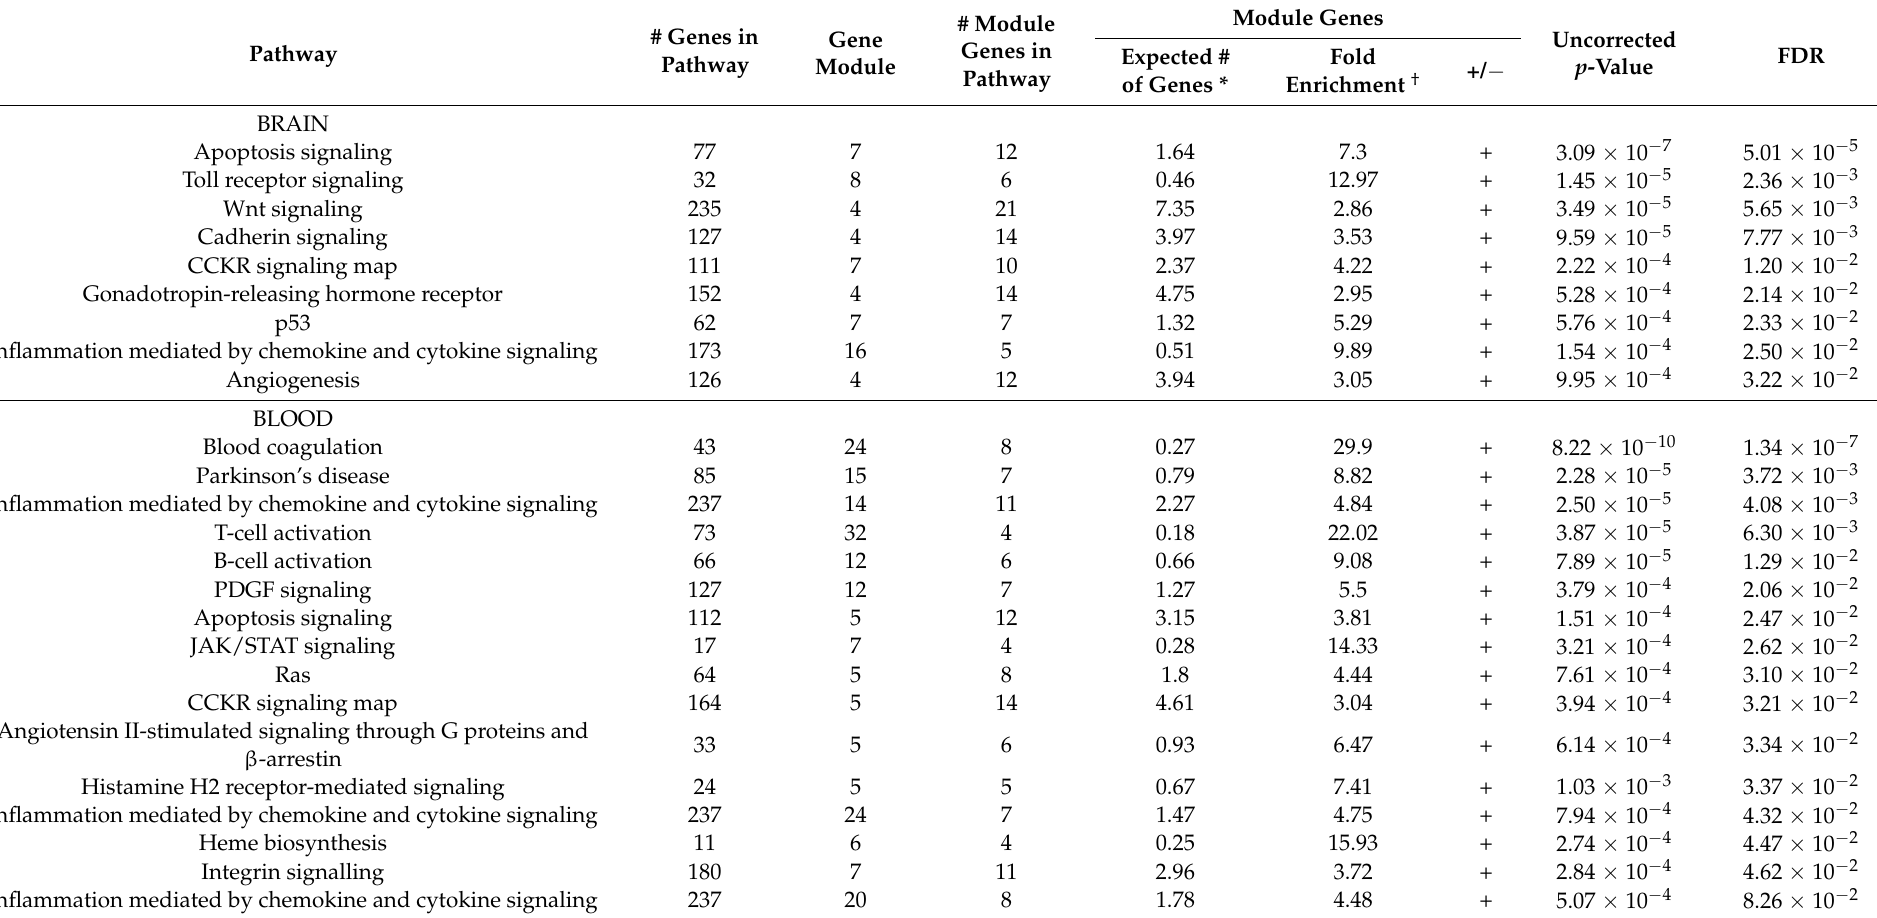
Table 3. Significant pathway enrichment in gene modules in the brain and